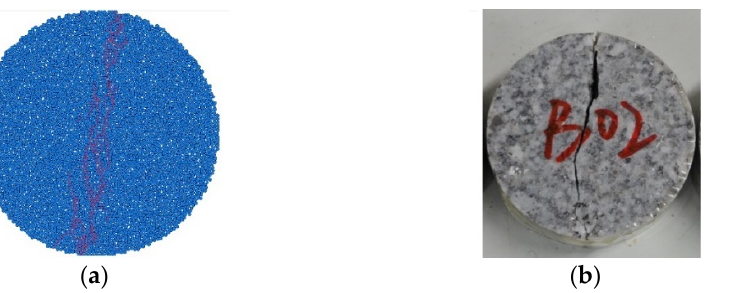
Figure 13. The material fractures under Brazilian splitting test. ( a ) DEM calculation with individual B; ( b ) Experiment.